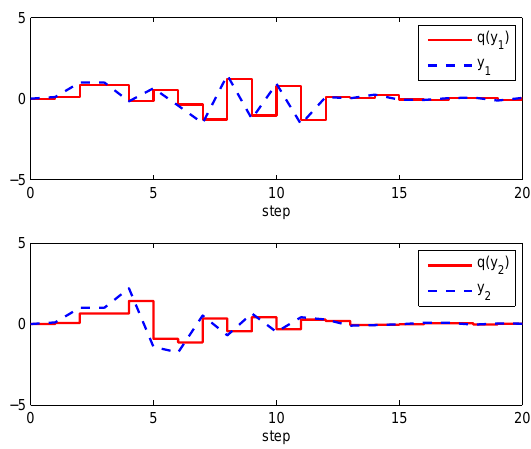
Figure 1: Parameters change of r(k)